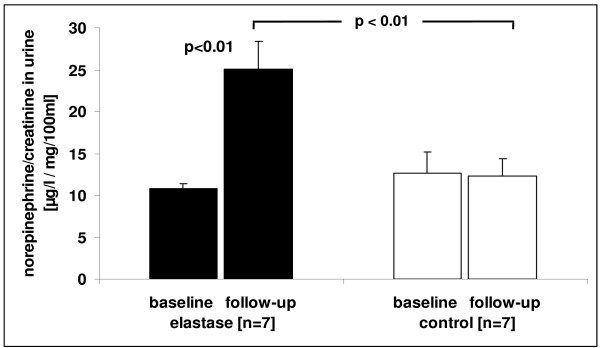
Norepinephrine (NE) concentration in urine of elastase treated mice (protocol 2) and controls. Repetitive administration of elastase lead to a significantly higher norepinephrine concentration at follow-up compared to control animals.